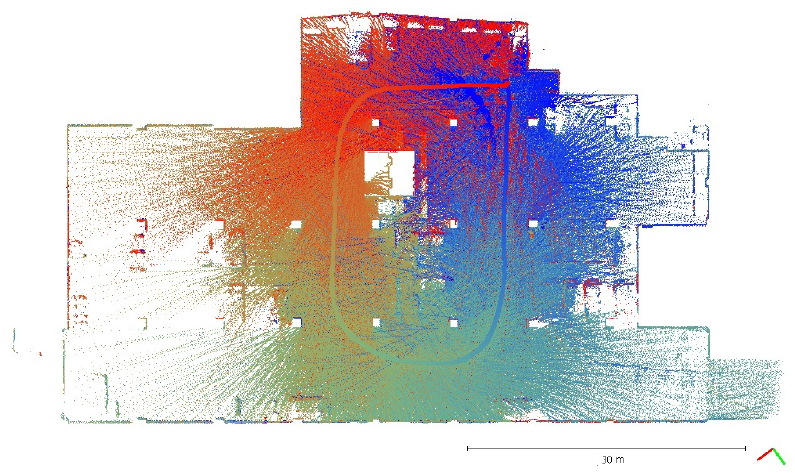
Figure 9. Point cloud colored by scanning time and the scanning trajectory of dataset DATA2.